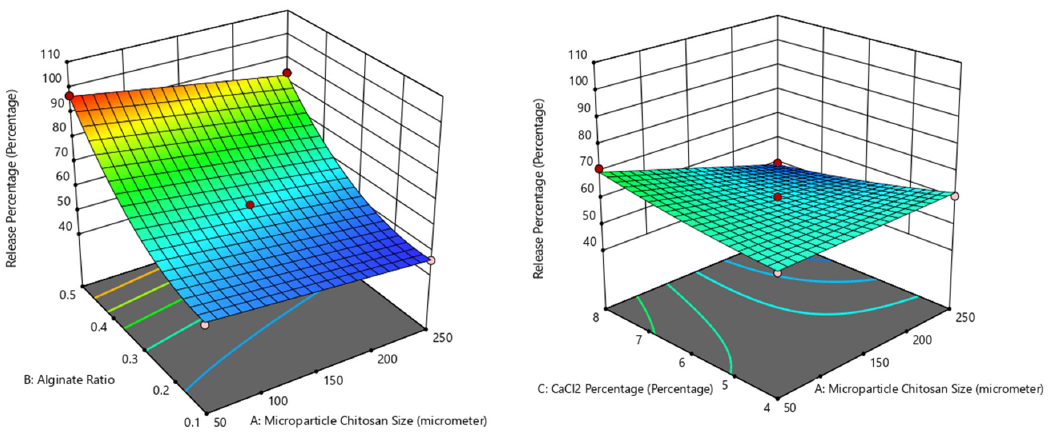
Figure 3. Dependence of mangostin cumulative release on (left) alginate:chitosan ratio and microparticle size and (right) CaCl 2 concentration and microparticle size.